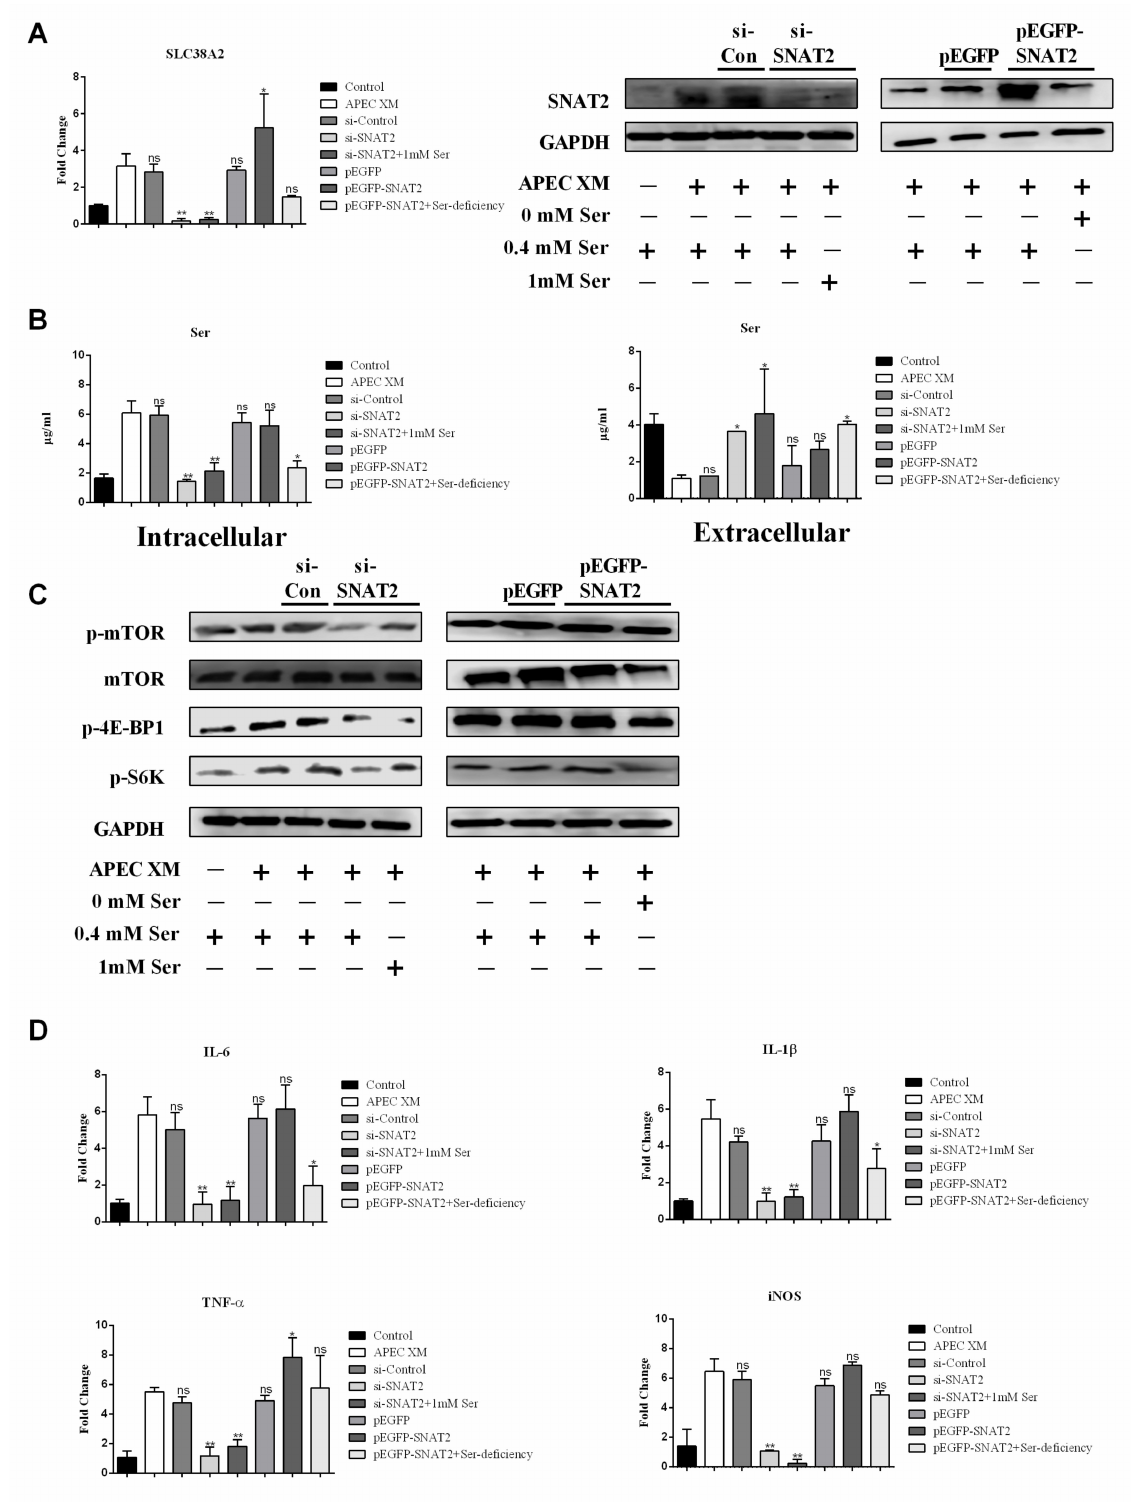
Figure 6. The effect of SNAT2 silencing and overexpression on Ser uptake, activation of the mTORC1 pathway, and inflammation. ( A ) The mRNA transcription and expression of Scl38a2 , respectively in SNAT2-silenced cells cultured in the complete or the 1 mM Ser supplement medium, or in SNAT2-overexpressed cells cultured in the complete or the Ser deficiency medium, compared with APEC XM-infected cells. GAPDH and GAPDH were used as the reference control for RT-PCR and the blotting. Data are from one experiment representative of three independent experiments, with three to six replicates per group. Data represent means ± SD. ( B ) The intracellular and extracellular content of Ser, respectively